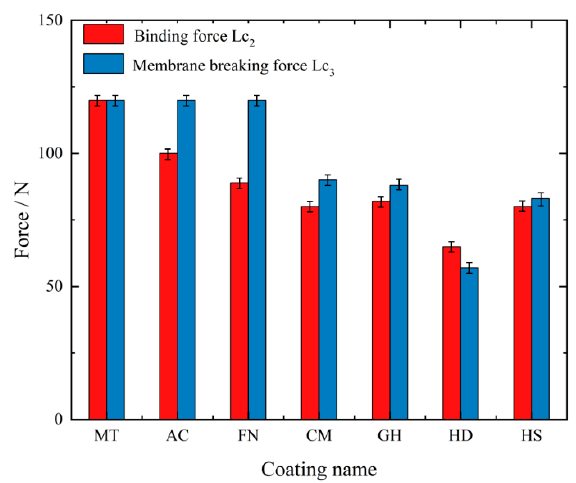
Figure 12. Binding force and membrane breaking force of each coating.